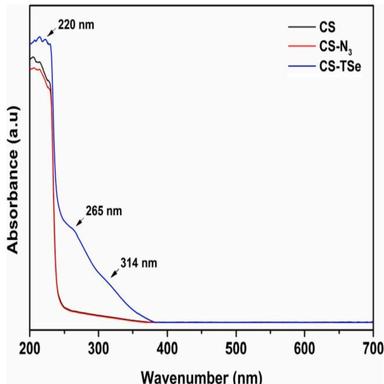
UV–Vis absorption spectra of CS, CS-N3, and CS-TSe using diluted solutions (10− 5 mmol L− 1 ) in DMSO.